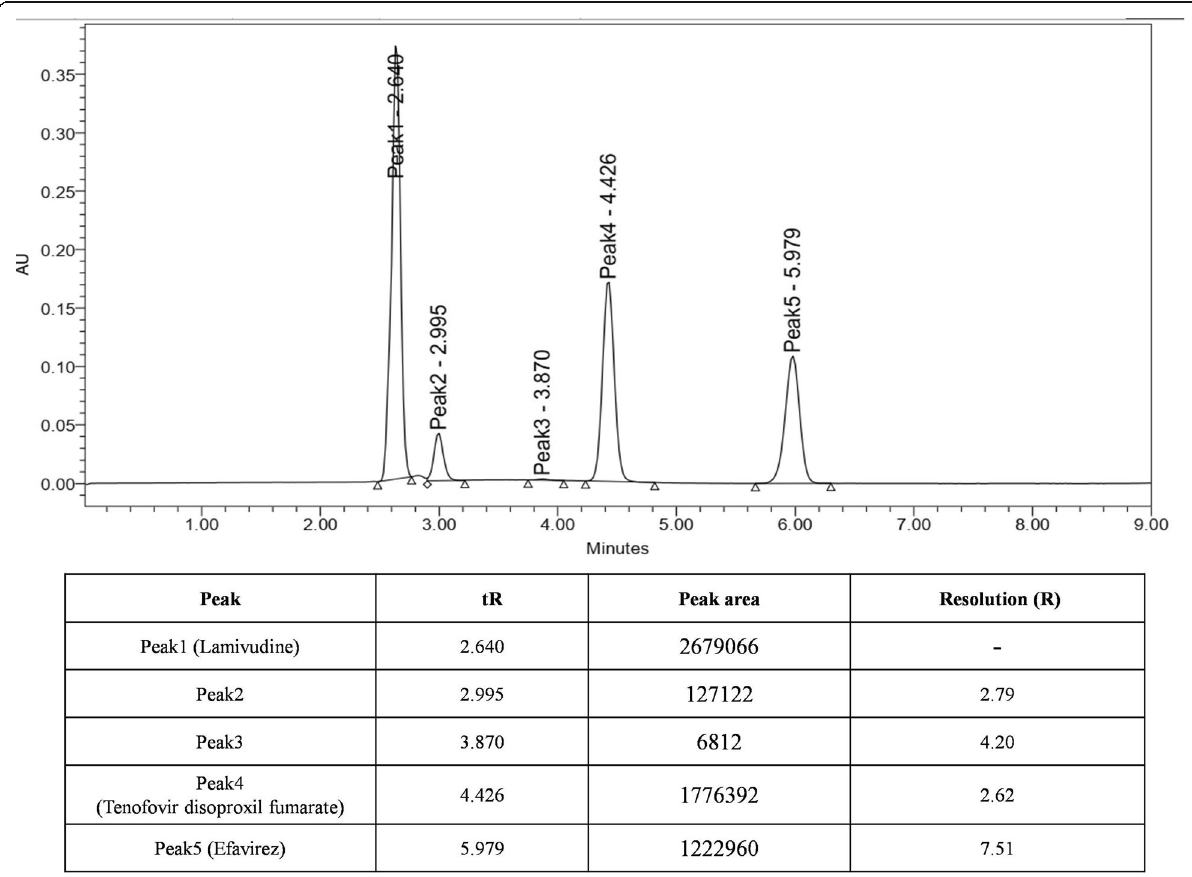
Fig. 8 Chromatogram of thermal degradation